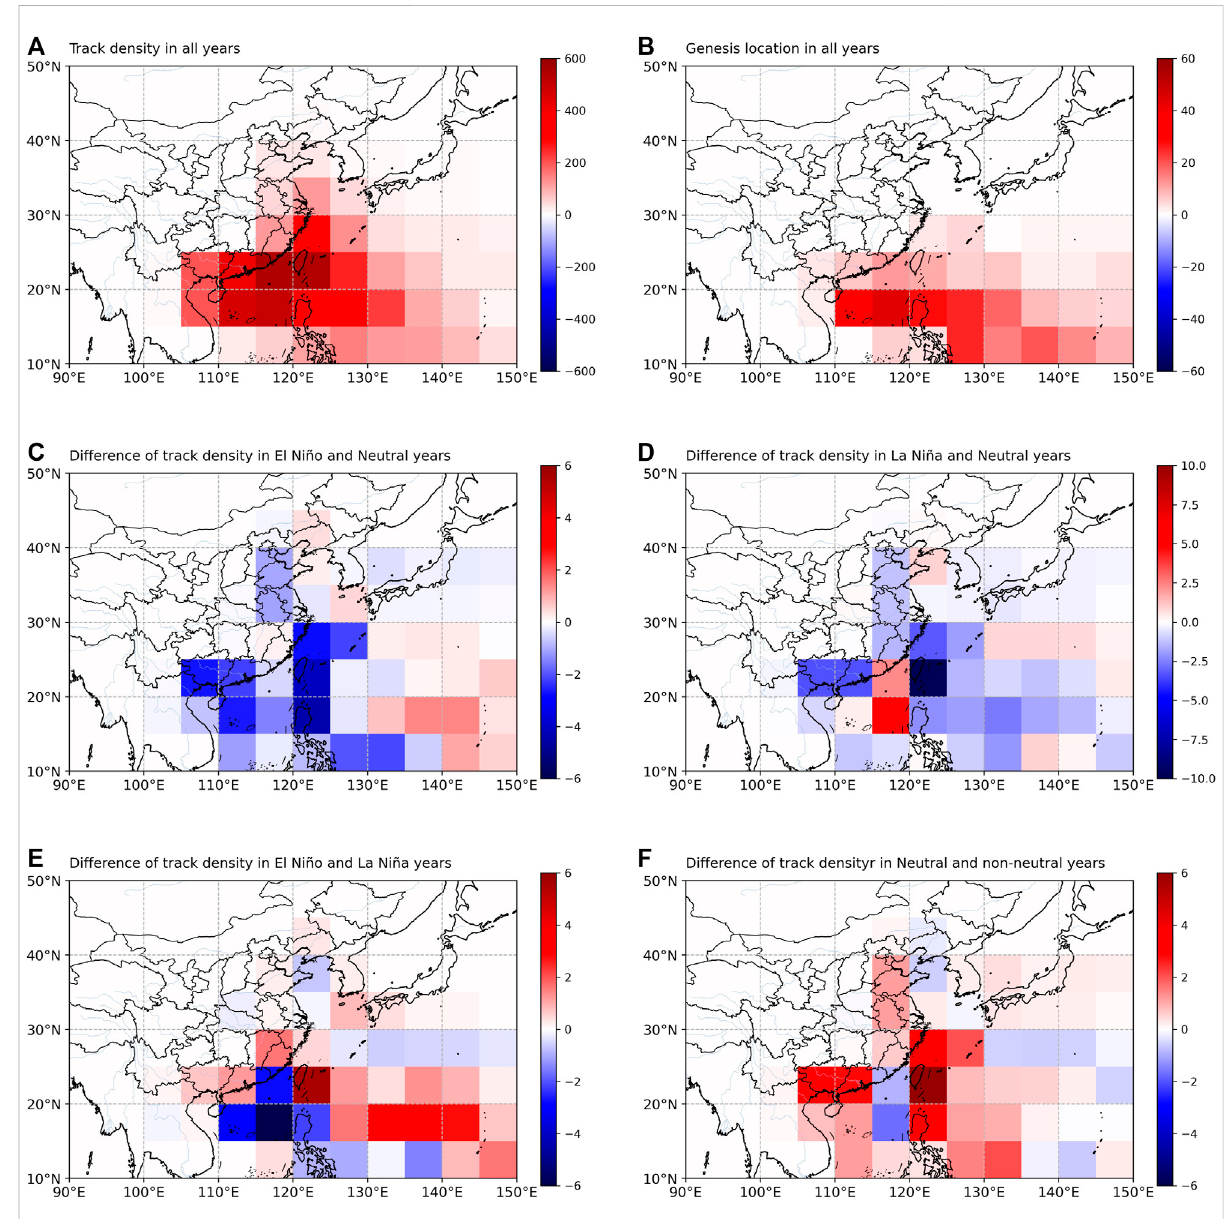
FIGURE 7 SpatialdifferencesinoveralltrackdensityoflandfallingTCsfor (A) allyears, (C) ElNiñoyears versus neutralyears, (D) LaNiñayears versus neutral years, (E) El Niño years versus La Niña years and (F) Neutral years versus non-neutral years. And spatial differences in genesis location of landfalling TCs for all years (B)